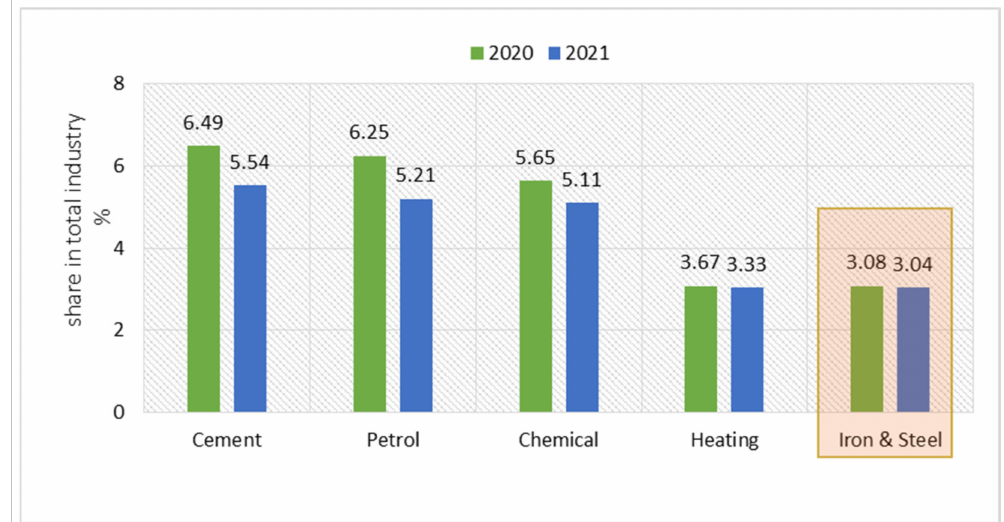
Figure 1. Share of Polish steel industry in total industry CO 2 emissions. Source: own elaboration based on [61].